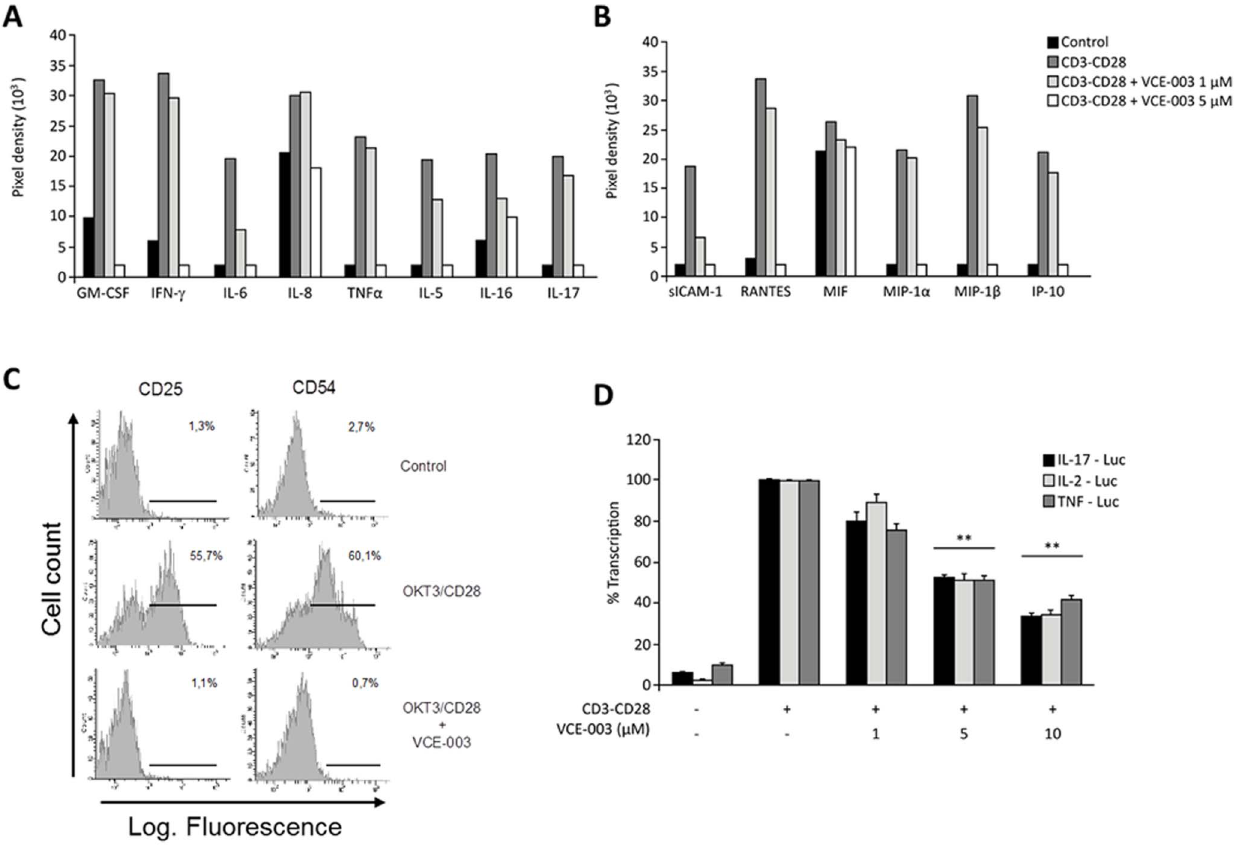
Figure 2. Effects of VCE-003 on T-cell activation. (A) Human peripheral T cells were stimulated for 72 h with the OKT3 (1 m g/ml) and anti-CD28 (0.5 m g/ml) mAbs in the presence or absence of increasing concentrations of VCE-003, and the culture supernatants were collected and assayed using a R&D Systems Human Cytokine Array system (A, cytokines; B, chemokines and sICAM-1). (C) Human peripheral T cells were stimulated as indicated in 2A for 72 h, and the expression of CD25 and CD54 was detected by flow cytometry. The numbers represent the percentage of CD25 + and CD54 +